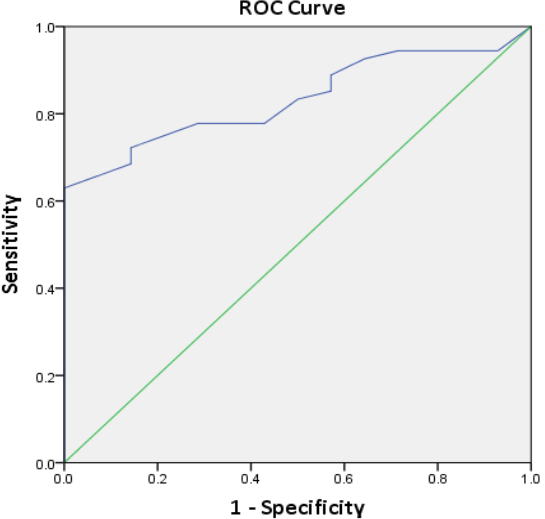
Figure 4. ROC curve based on HIF-1 α weighted histoscores (HS) in NOM and OSCC samples. AUC = 0.833 (95% CI, p < 0.001).